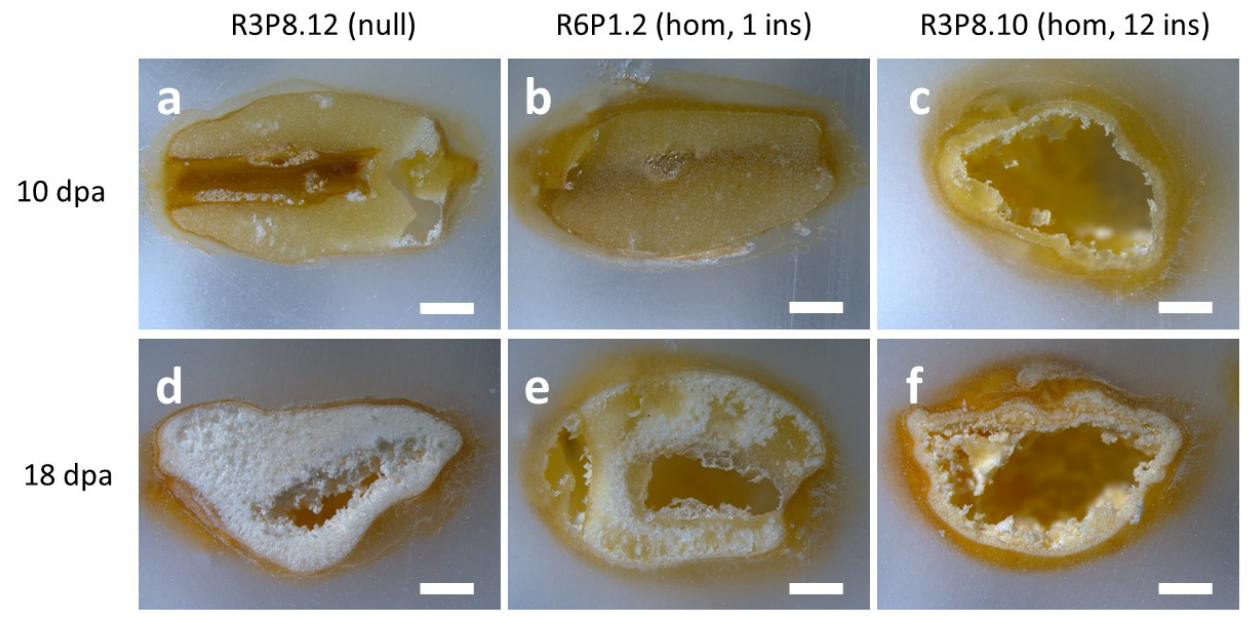
Figure 6. Photos of fixed and paraffin embedded caryopses from greenhouse grown AsWRI1 -wheat. ( a , d ) line R3P8.12; null (control), ( b , e ) R6P1.2; homozygous with one gene insert, and ( c , f ) R3P8.10; homozygous with 12 gene inserts. ( a – c ) 10 days post anthesis (dpa) and ( d – f ) 18 dpa. Scale bars are 1 mm long.